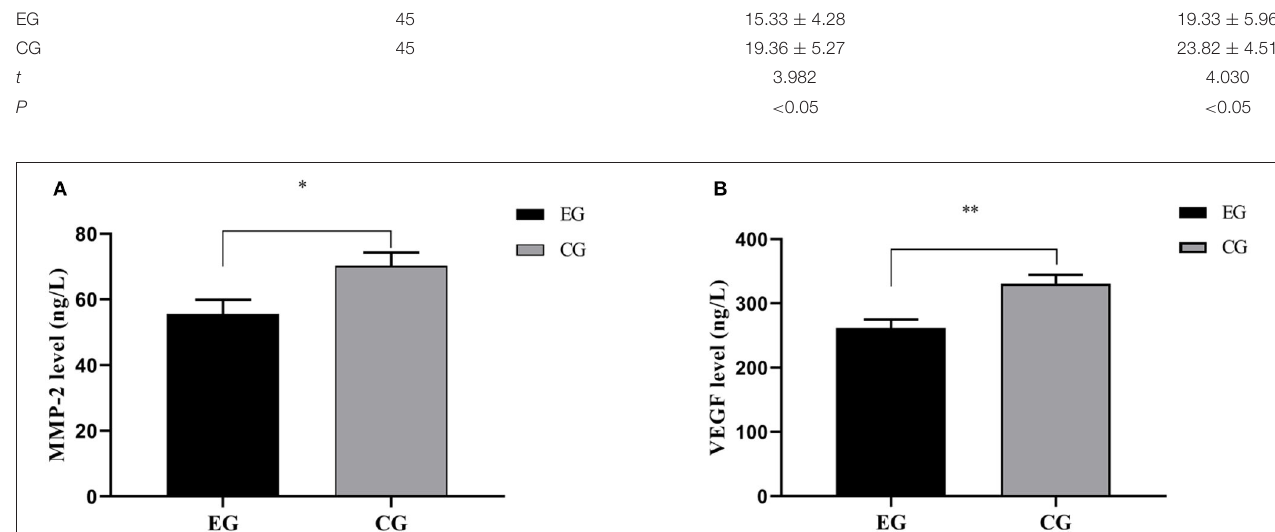
FIGURE 1 | Comparison of serological indicators [Mean ± SD]. (A) Comparison of MMP-2 levels. The abscissa represented EG and CG, and the ordinate represented the MMP-2 level (ng/L). The MMP-2 levels of EG and CG were (55.61 ± 4.28) ng/L and (70.27 ± 4.06) ng/L, respectively. * Indicated an obvious difference in the MMP-2 levels between the two groups ( t = 16.670, P < 0.001). (B) Comparison of VEGF levels. The abscissa represented EG and CG, and the ordinate represented the VEGF level (ng/L). The VEGF levels of EG and CG were (261.86 ± 13.29) ng/L and (330.83 ± 14.09) ng/L, respectively. ** Indicated an obvious difference in the VEGF levels between the two groups ( t = 23.887, P < 0.001).